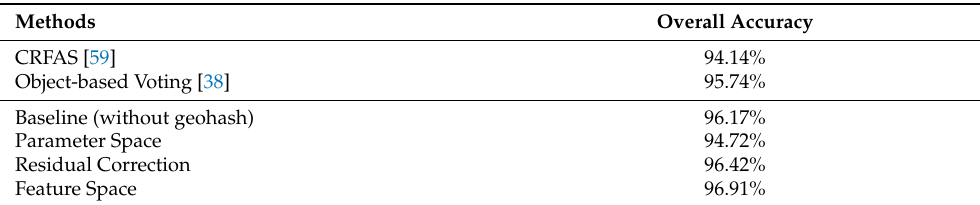
Table 3. Accuracy of the binary geohash on the GID